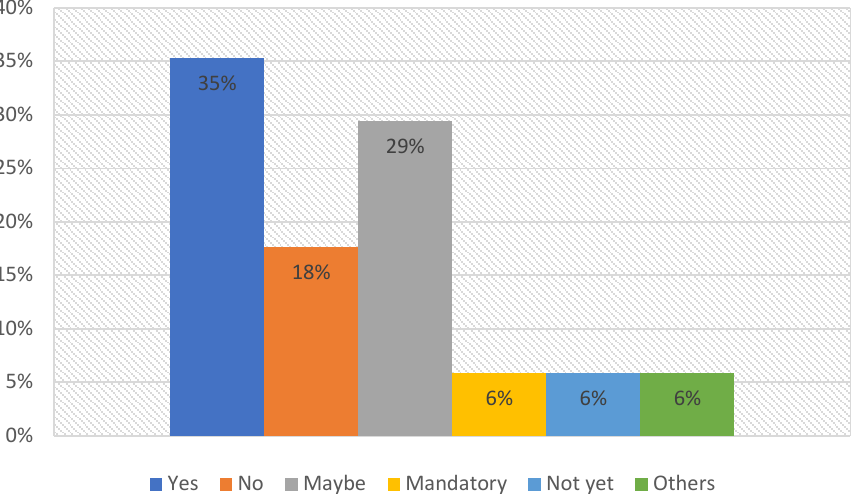
Figure 2. Plan for using alternative fuel.